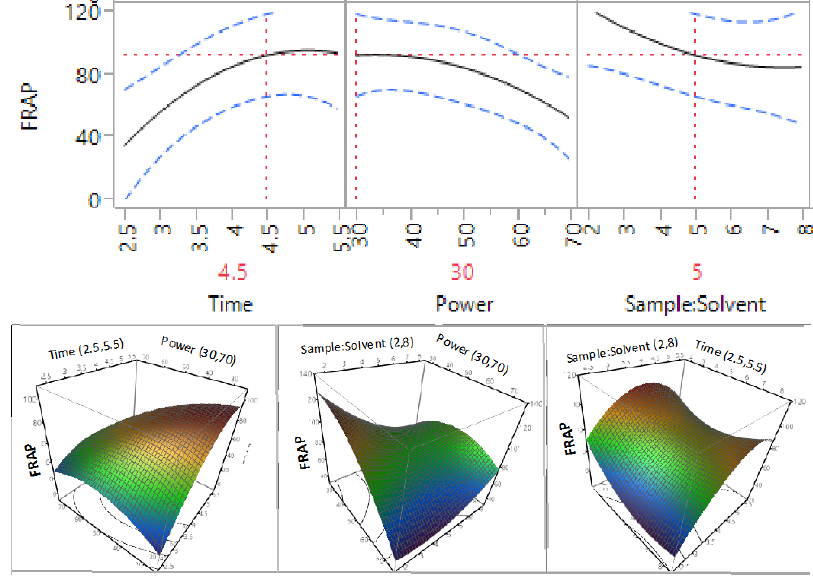
Figure 10. Impact of time (2.5–5.5 min), power (30%–70%, 360–840 W) and sample-to-solvent ratio (2–8 g/100 mL) on FRAP antioxidant capacity (µM TE/g).